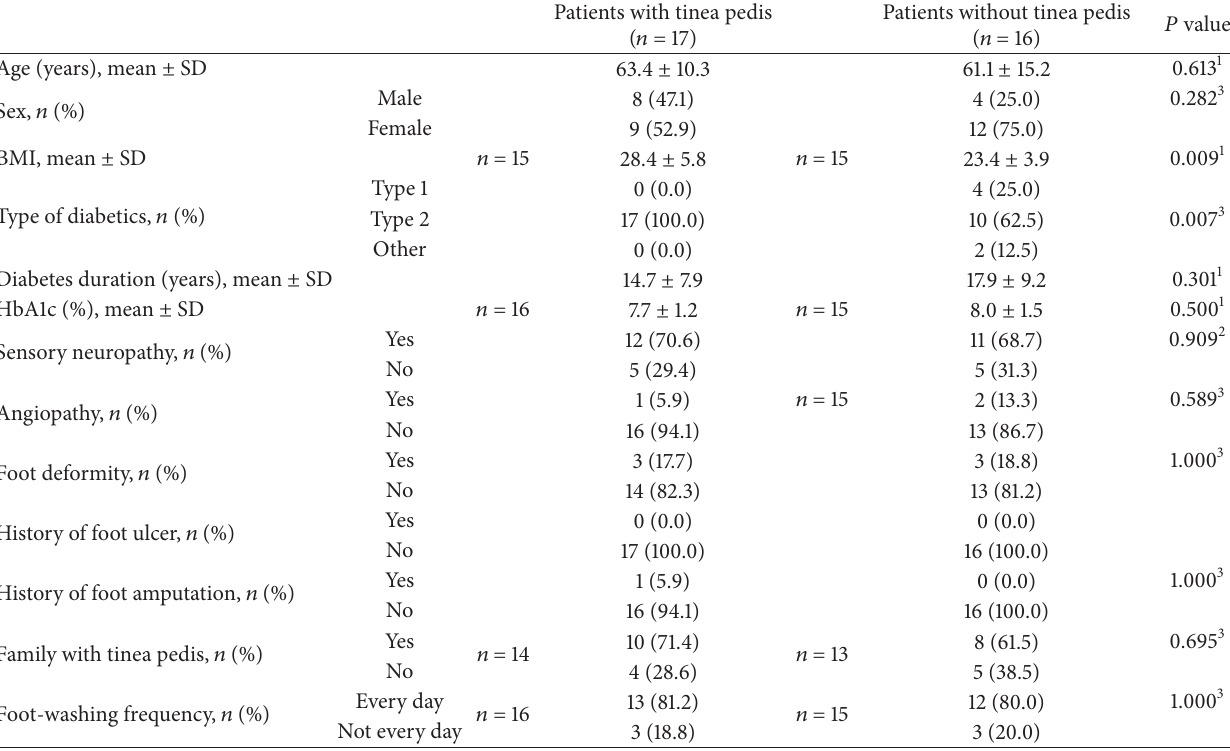
Table 2: Characteristics of diabetic patients with or without tinea pedis. Patients with tinea